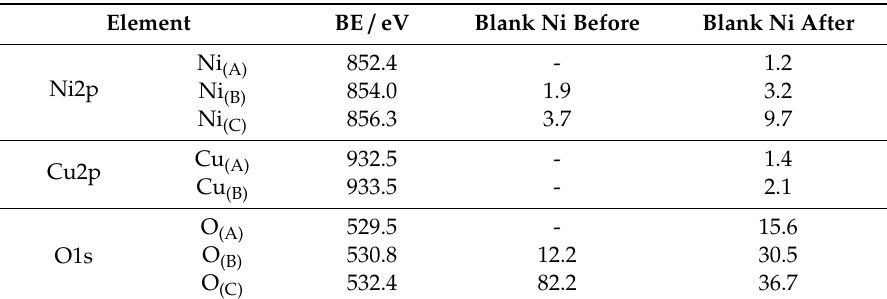
Table 3. Spectral deconvolution performed for blank Ni